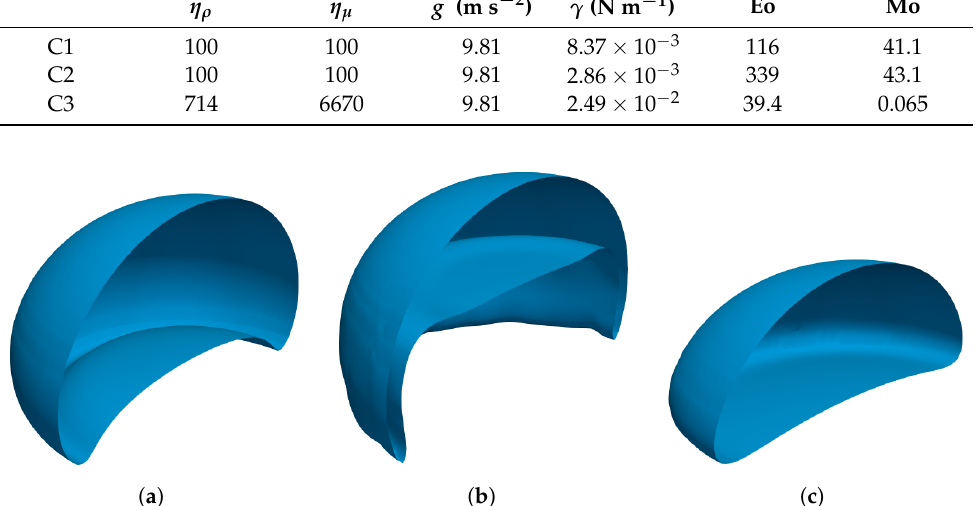
Figure 7. Bubble shape at the end of the transient for cases C1 ( a ), C2 ( b ) and C3 ( c ) represented through the half contour r α =